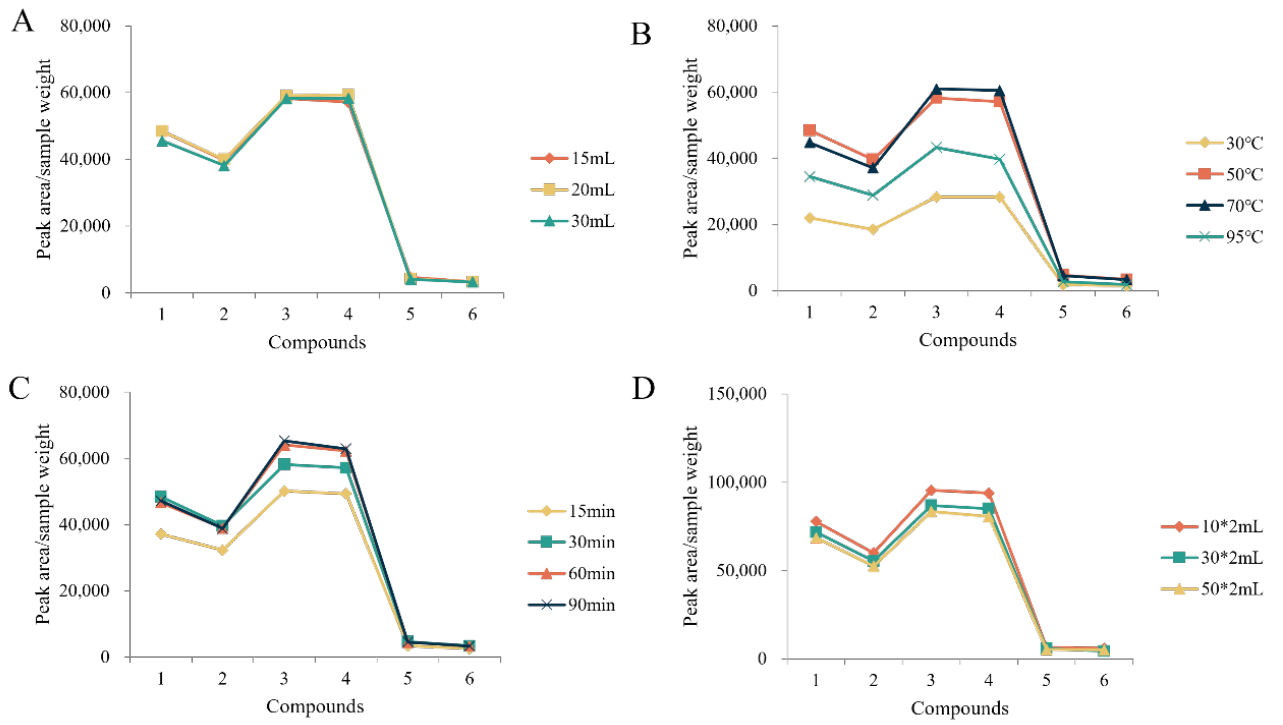
Figure 2. Optimization of different parameters of total dianthrones sample solution: ( A ) volume of dilute hydrochloric acid, ( B ) hydrolysis temperature, ( C ) hydrolysis time, and ( D ) volume of extraction solvent. Compounds: Trans -emodin-emodin dianthrones (1), cis -emodin-emodin dianthrones (2), trans -emodin-physcion dianthrones (3), cis -emodin-physcion dianthrones (4), trans -physcion-physcion dianthrones (5) and cis -physcion-physcion (6).